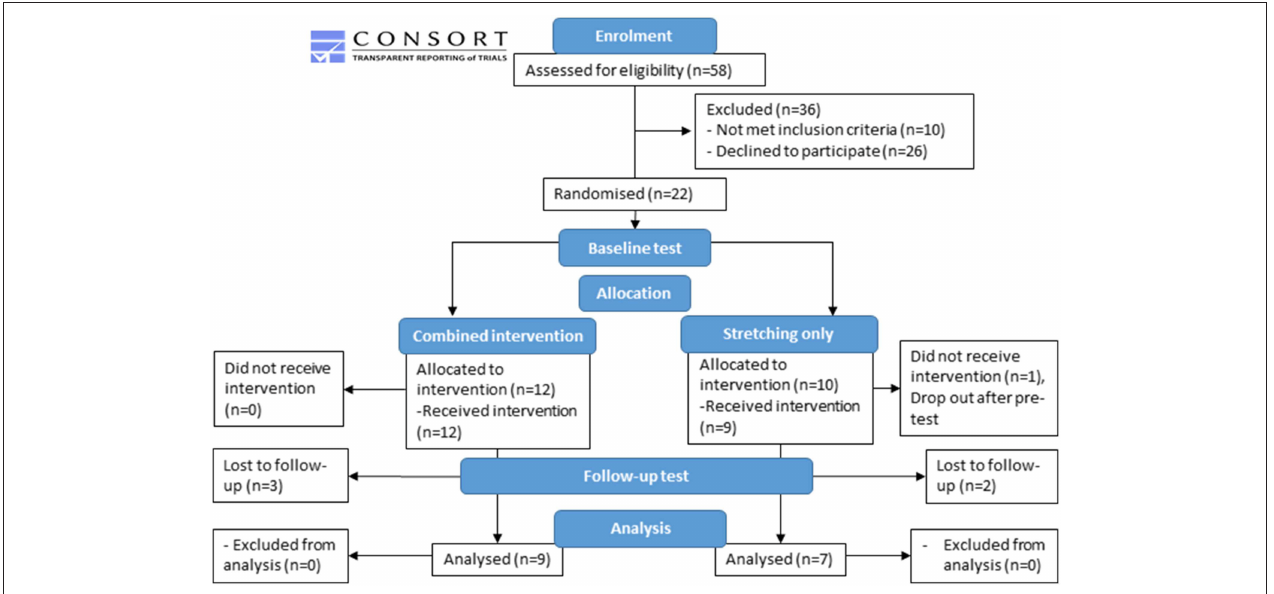
FIGURE 1 | Flow diagram based on consort guidelines to show the experimental